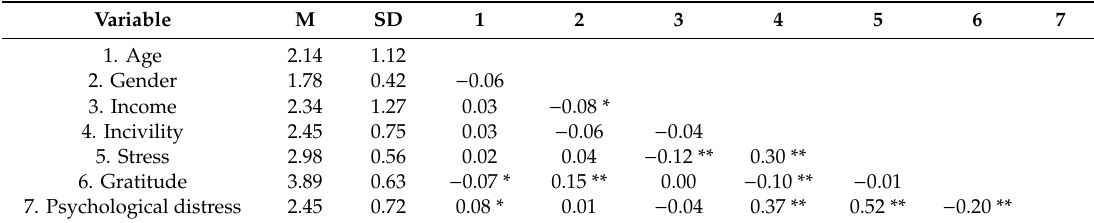
Table 1. Means, standard deviations, reliabilities, and intercorrelations between